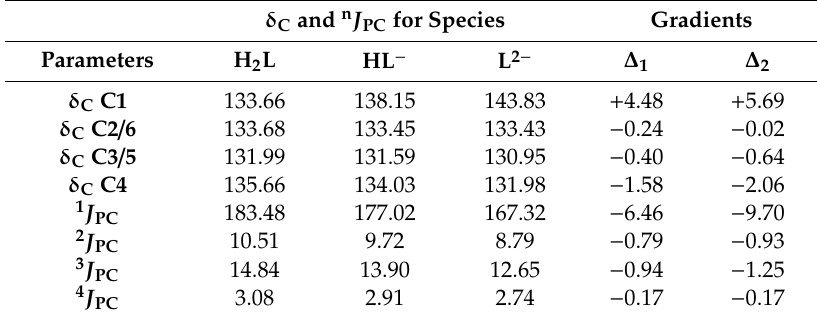
Table 4. Specific chemical shifts δ C [ppm] and coupling constants n J PC (n = 1 to 4) [Hz] for the 13 C{ 1 H}-